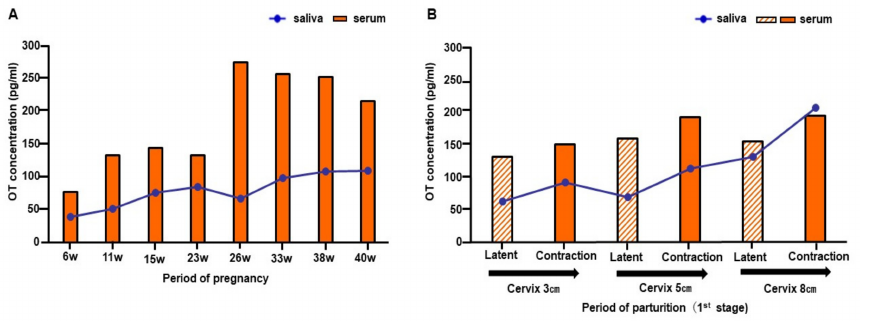
Figure 1. Changes in salivary and serum oxytocin (OT) from early pregnancy to the labor of one woman. ( A ) Salivary and serum OT concentrations from gestation weeks 6 to 40. ( B ) Salivary and serum OT concentrations in the first stage of